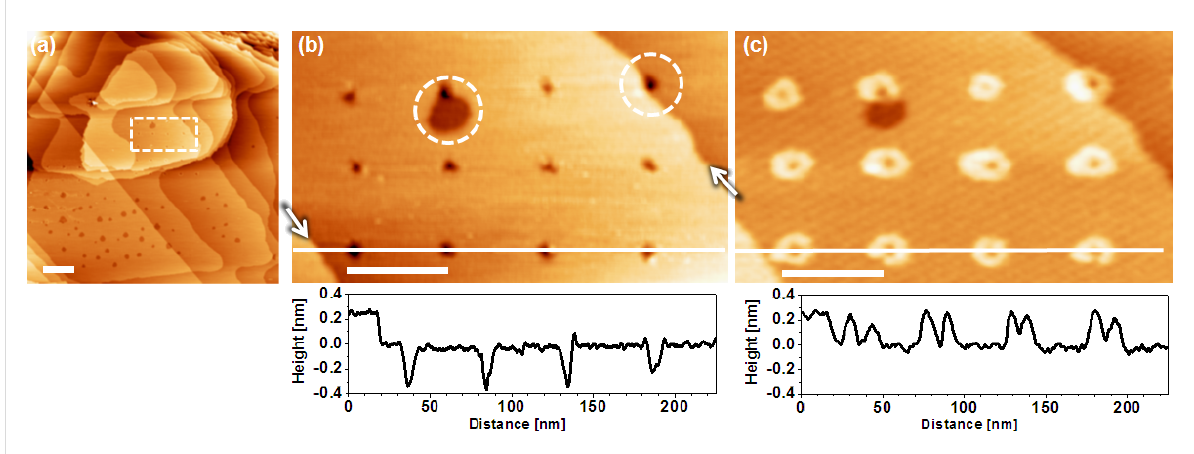
Figure 2: Cu-UPD on Au templated by a patterned BP2 SAM. a) Large scale STM image of the surface before deposition recorded in air. (b) Magni- fied image of area marked in (a) revealing an array of point defects created by voltage pulses of 4.5 V applied to the STM tip for 50 ms. Steps in the Au substrate are highlighted by the arrows. Dashed circles mark defects at the edge of a vacancy island and step, respectively. (c) In situ electro- chemical STM image of the same area after Cu-UPD of 30 min at 0.275 V vs Cu 2+ /Cu. Height scales in the line profiles are normalised to the Au step height of 2.5 Å. All scale bars 50